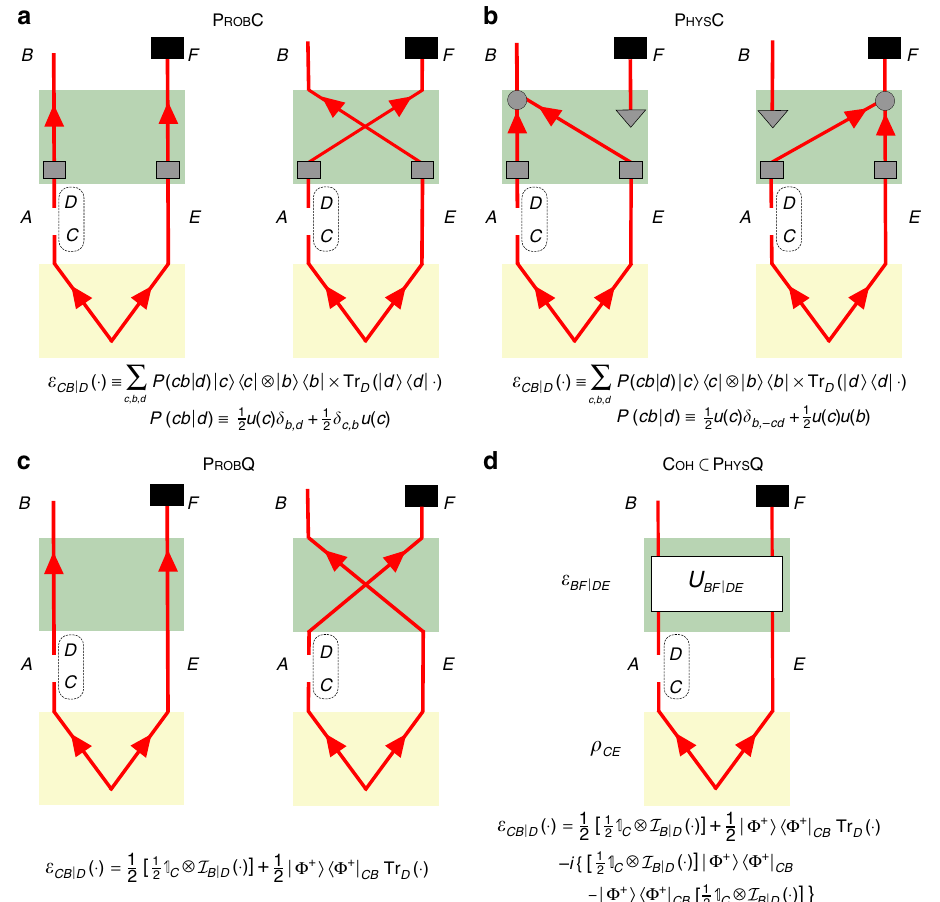
Figure 4 | Quantum circuits which realize examples of different classes of causal relations between two qubits. Circuits for four combinations of cause-effect and common-cause mechanisms: ( a ) P ROB C, ( b ) P HYS C, ( c ) P ROB Q and ( d ) C OH C P HYS Q. In all circuits, C and E are initially prepared in the maximally entangled state F þ j i and F is discarded at the end. The examples differ only in the choice of the gate E BF j DE , as described in the text. Panels with two circuits represent an equal probabilistic mixture of both scenarios. Black squares represent the trace operation, grey squares represent complete-dephasing operations, grey triangles represent preparations of the completely mixed state, grey circles represent the classical XNOR gate, which sets b ¼ (cid:5) ed for binary variables b , e , d taking the values { ± 1} and the two-qubit unitary U BF | DE is the partial swap given by equation (2). Below each example, we specify the causal map E CB j D obtained from the state r CE and the gate E BF j DE via E CB j D ð(cid:4)Þ¼ Tr F (cid:7) E BF j DE (cid:4) (cid:3) r CE ð represent classical binary variables, P ( cb | d ) represents a conditional probability distribution over these, d x , y denotes the Kronecker delta function and u ( x ) denotes the uniform distribution over x